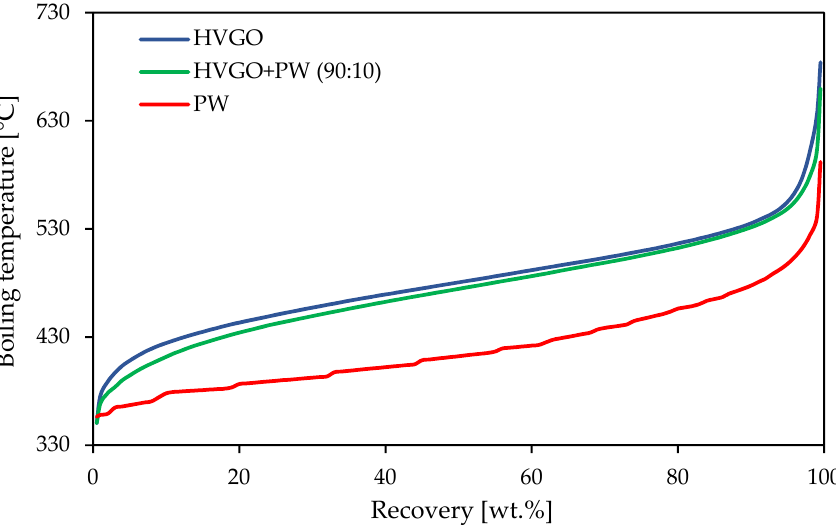
Figure 1. The distillation profiles of HVGO, PW and the mixed feedstock (simulated distillation).